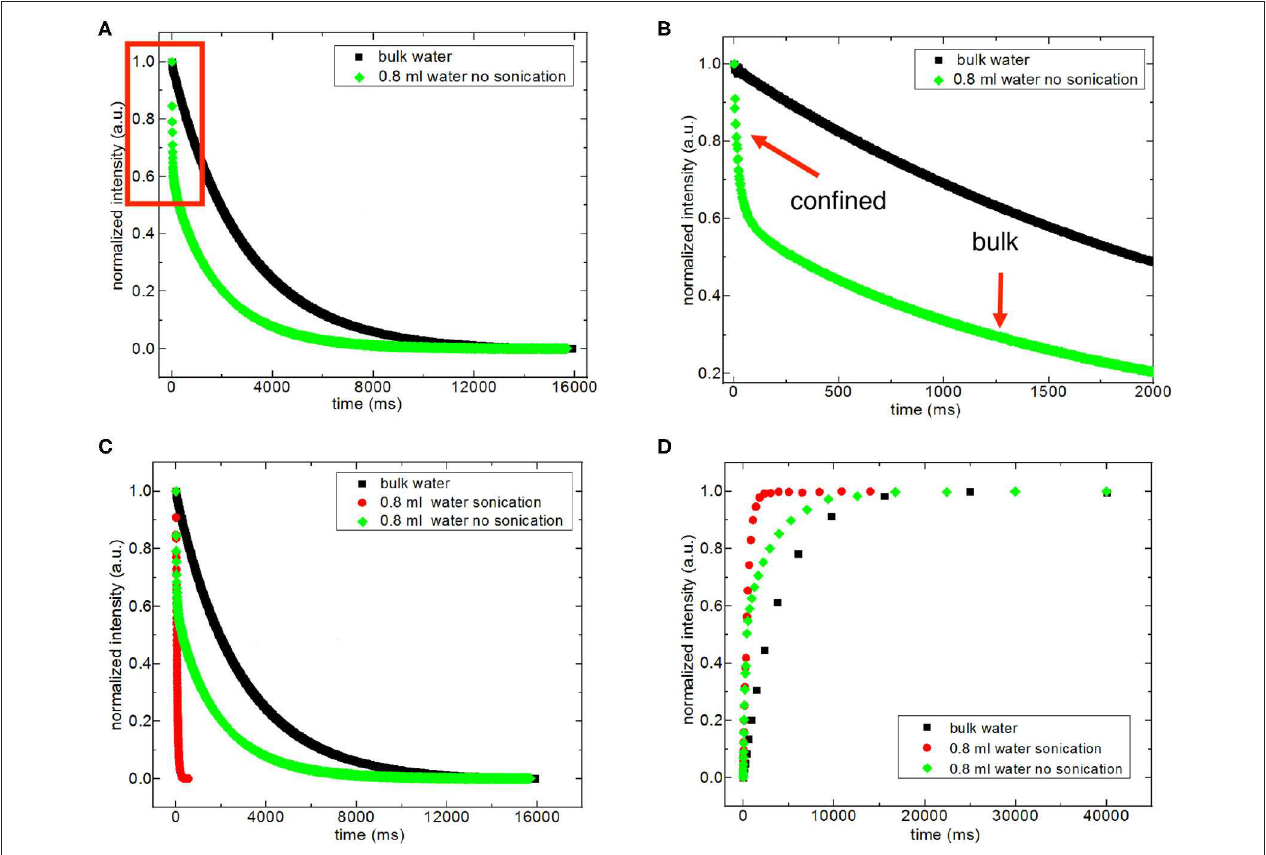
FIGURE 1 | Representative comparison of T 2 data of 0.8ml water in the mixture with 150mg silica-4.0nm (S/V = 574) with and without sonication acquired at 40 ◦ C (A–C) . (B) is the zoom in for the red box in (A) . Representative comparison of T 1 data of 0.8ml water in 150mg silica-4.0nm with and without sonication acquired at 40 ◦ C (D)